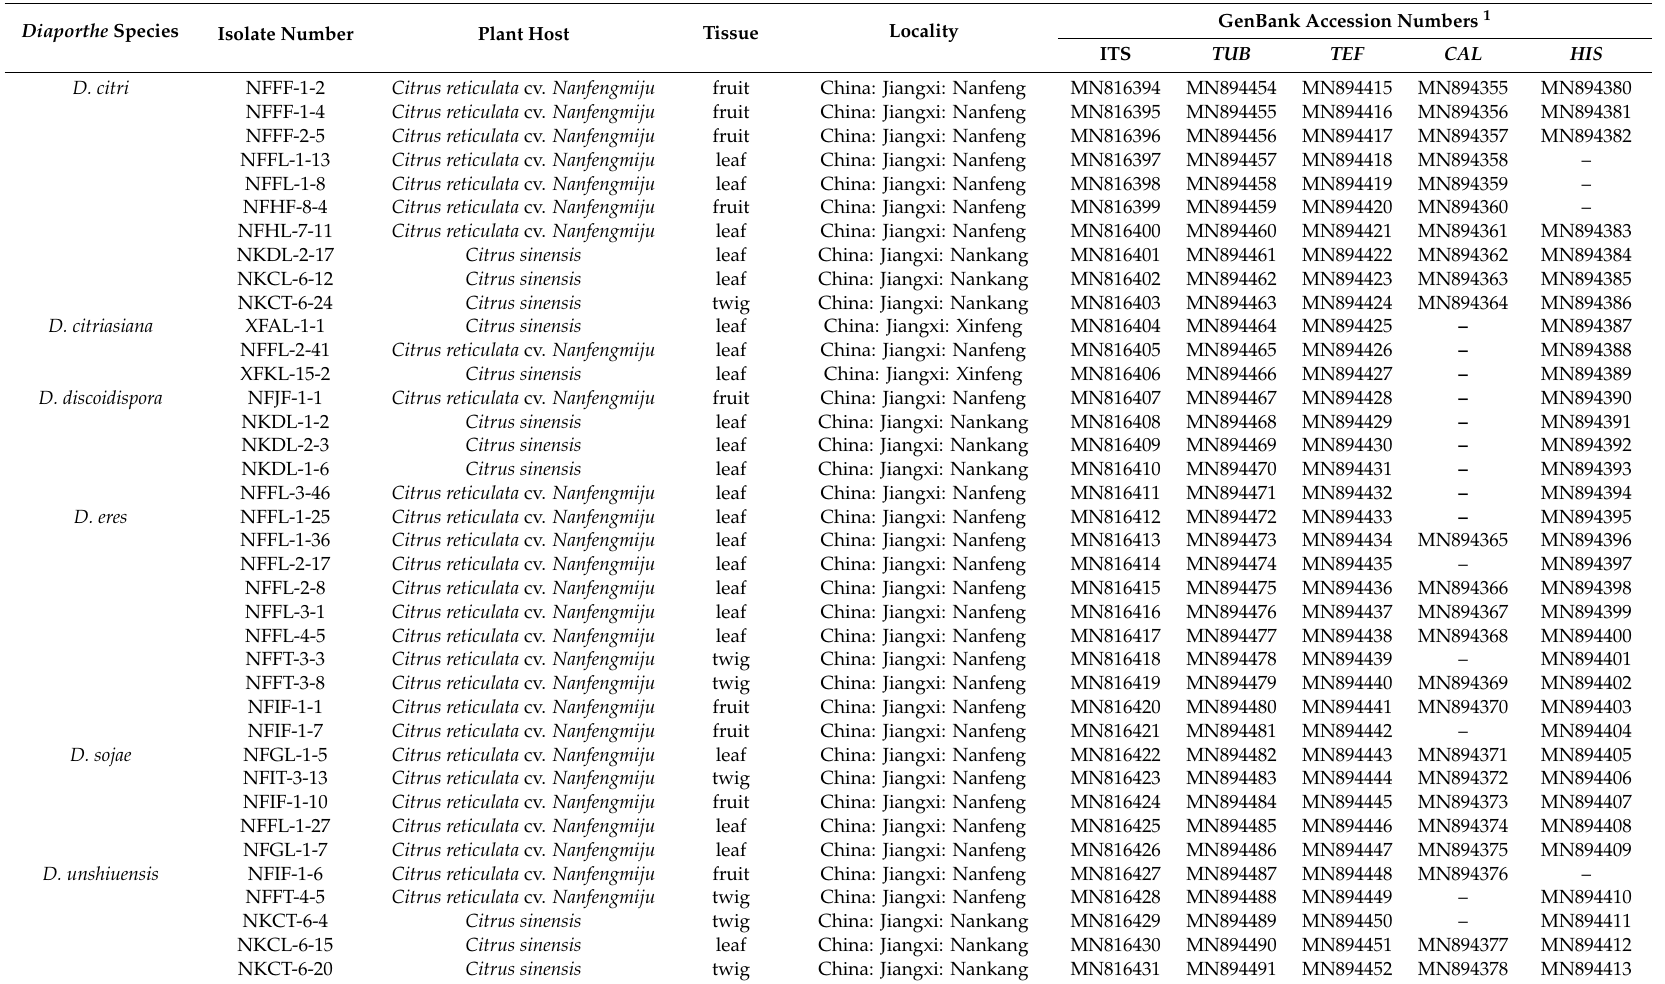
Table 1. Collection details and GenBank accession numbers of isolates included in this